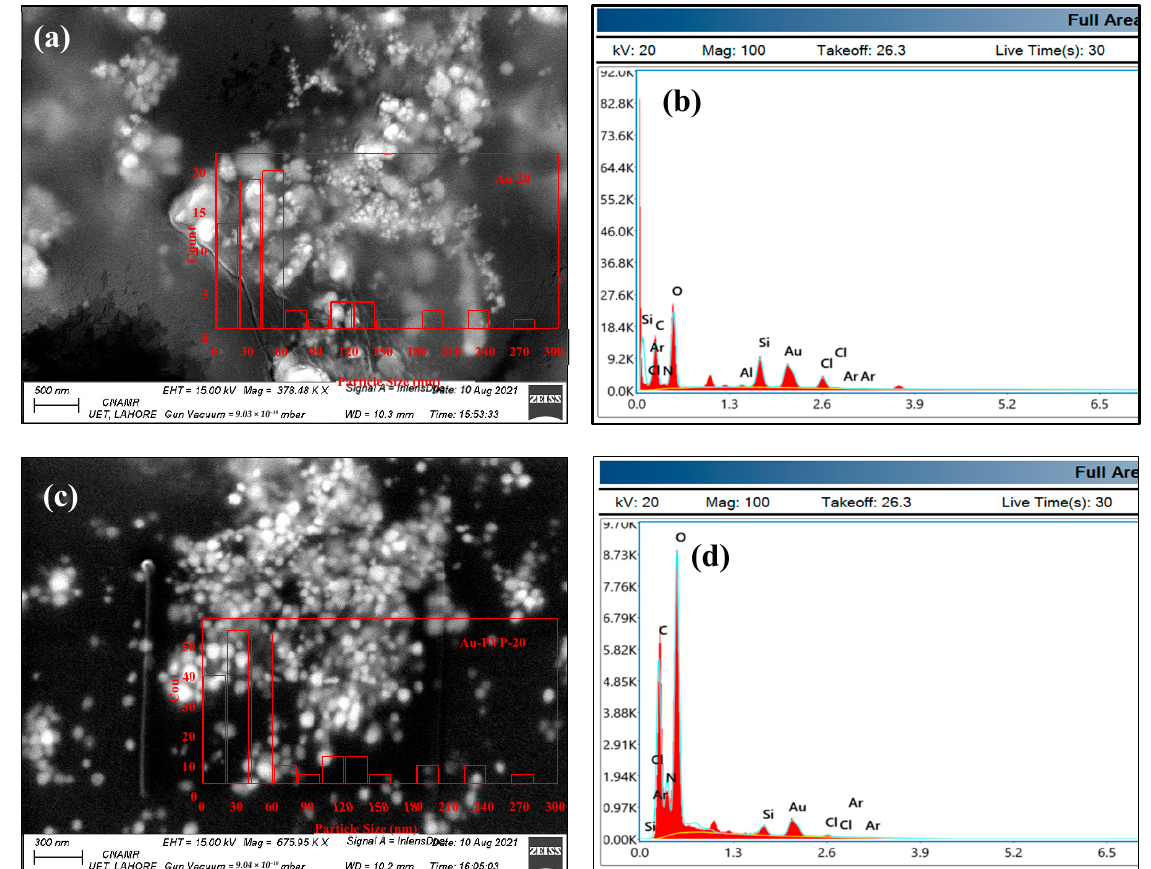
Figure 5. SEM Micrograph of ( a ) Au-20 and ( c ) Au-PVP-20 ( b ) EDX of Au-20 and ( d ) EDX of Au-PVP-20. The inset in ( a , c ) exhibit the respective size distribution of the nanostructured Au particles and nanostructured gold-PVP composites.